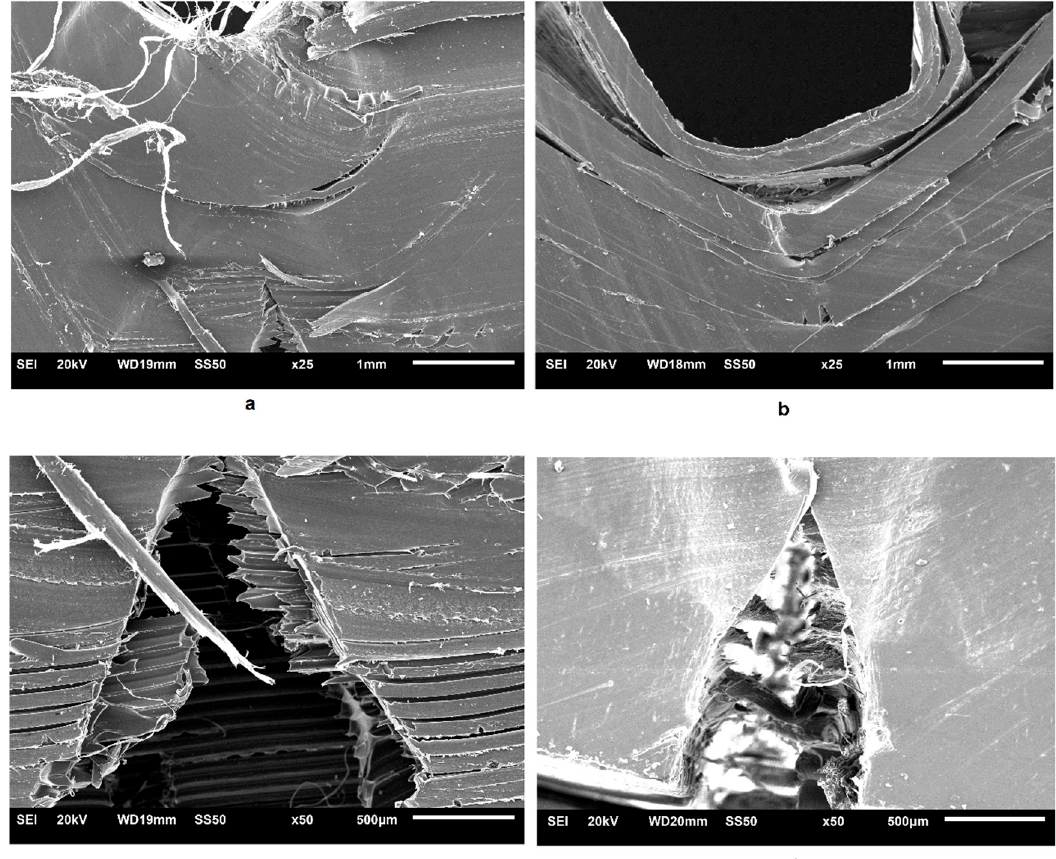
Figure 7. Scanning Electron Microscope (SEM) images showing details of the fractured surfaces of the ILSS samples. ( a ) Failure mode of PLA 3D850 samples (25×) and ( b ) failure mode of PLA-Graphene composite samples (25×) ( c ) and ( d ) Details of the fractured surfaces of PLA 3D 850 and PLA-Graphene samples, respectively (50×).